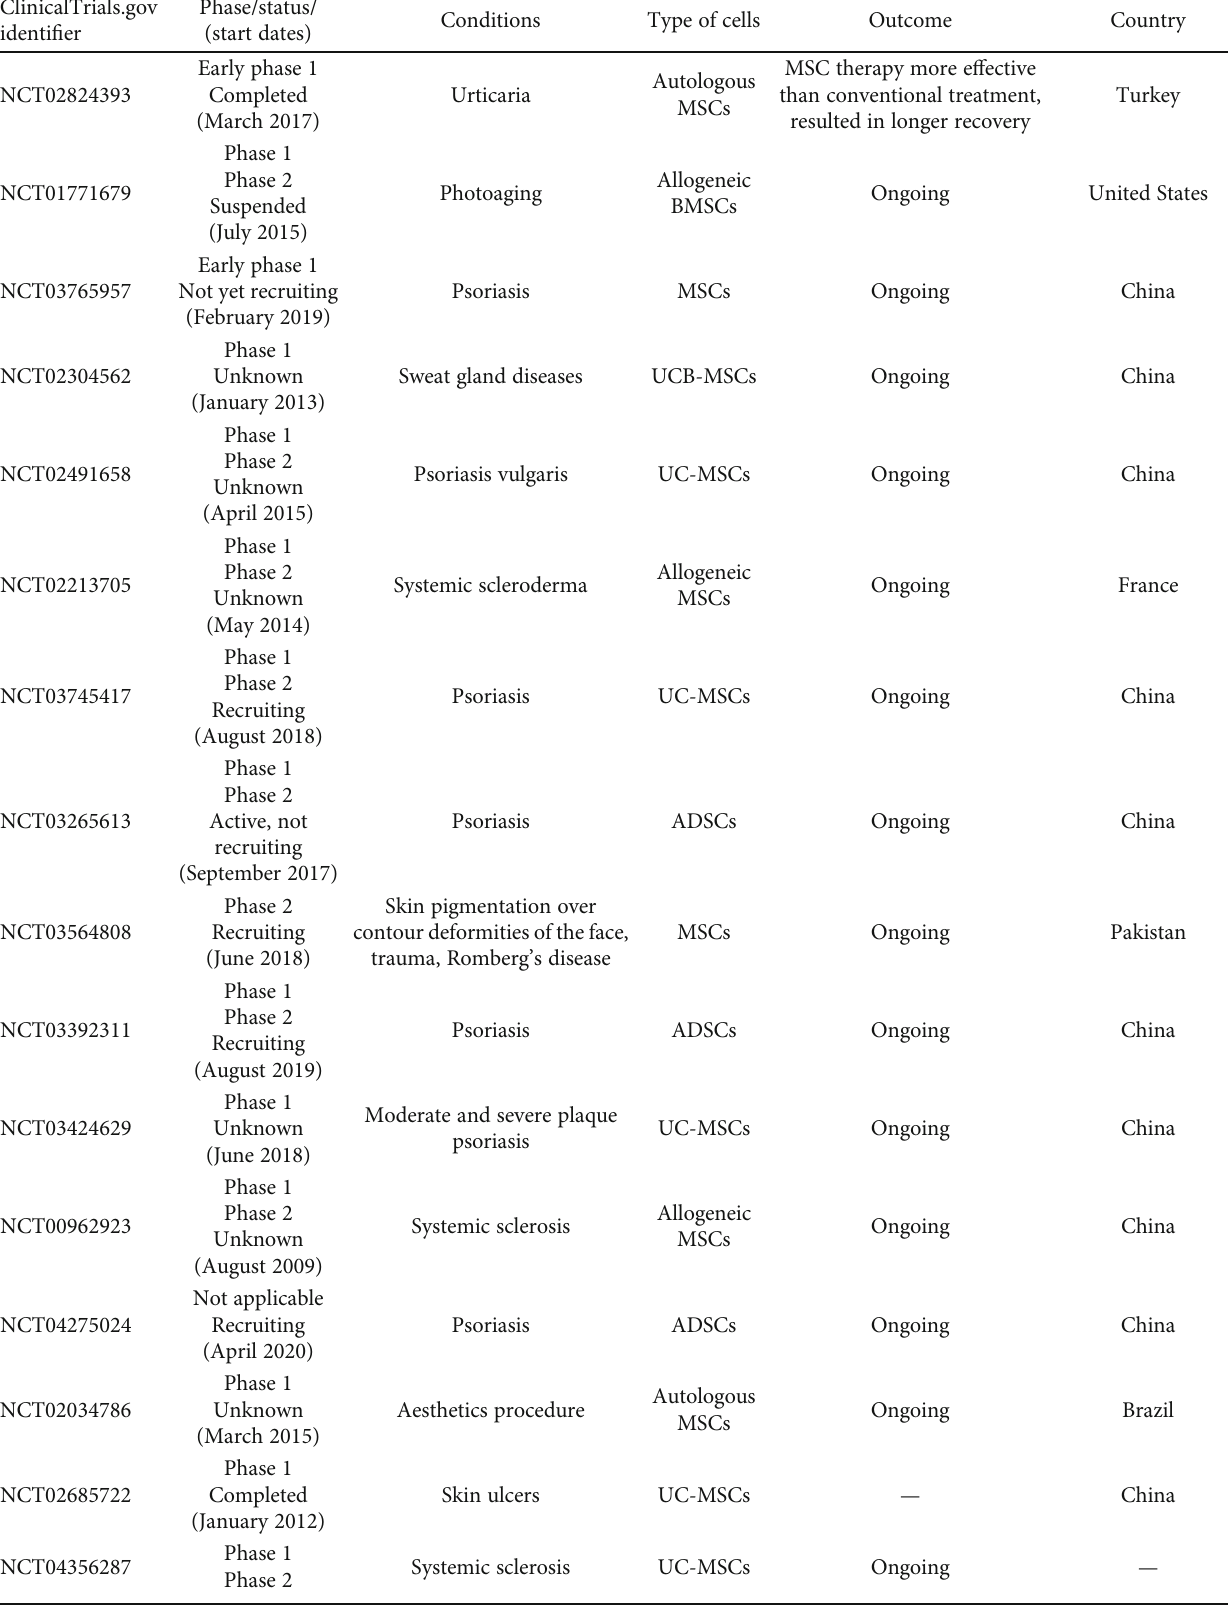
Table 1: MSC-based clinical trials for cutaneous